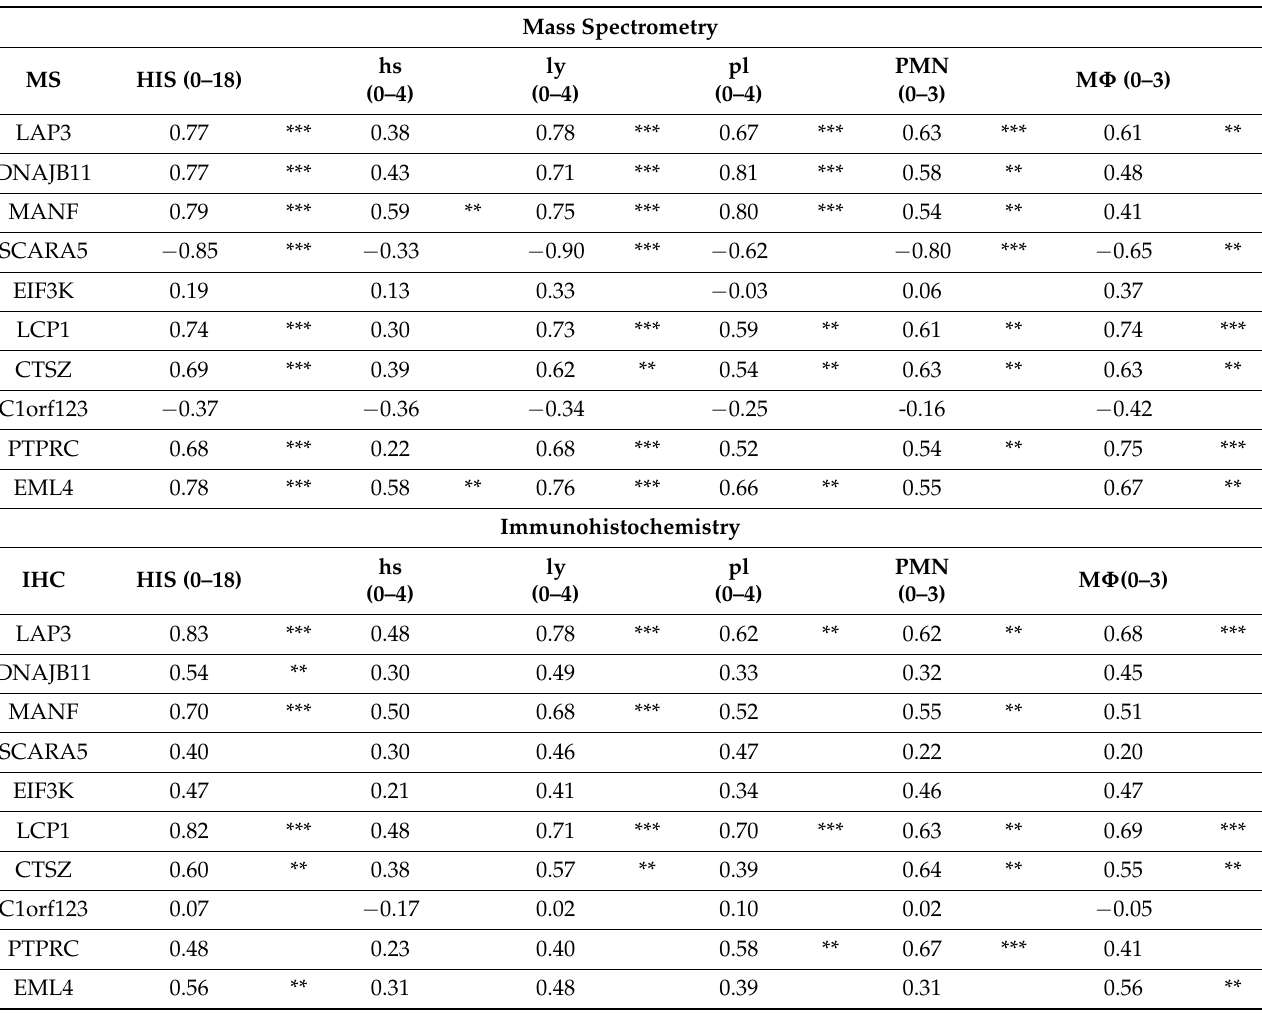
Table 1. Correlation between quantified proteins and each parameter of the histological inflamma- tory scoring (HIS). Mass spectrometry: correlation parameters calculated by correlating MS-Log2 protein intensities and HIS parameters. Immunohistochemistry: correlation parameters calculated by correlating IHC-protein intensities and HIS parameters. MS, mass spectrometry; IHC, immunohisto- chemistry; HIS, histological inflammatory scoring; hs, hyperplasia; ly, lymphocyte; pl, plasmocyte; PMN, polymorphonuclear neutrophils; M Φ , macrophage. Methods used for quantifying protein intensities are in bold print. ** P < 0.01 and *** P < 0.001. Mass